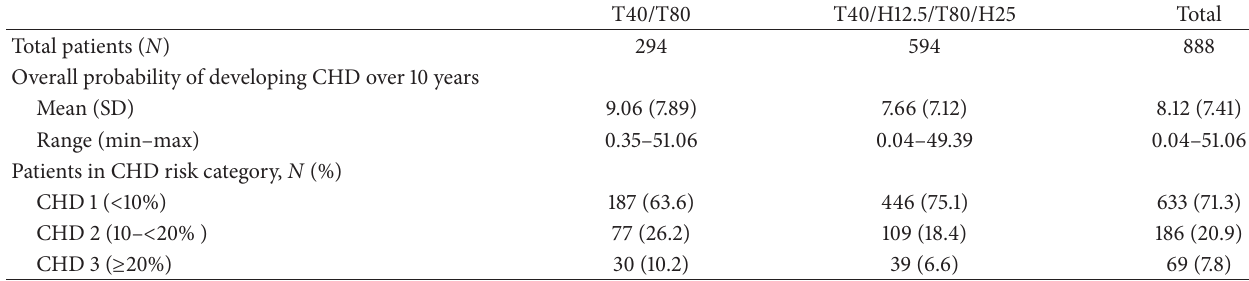
Table 2: Probability of developing CHD over 10 years: descriptive statistics and distribution of patients within estimated 10-year CHD risk categories, based on treated